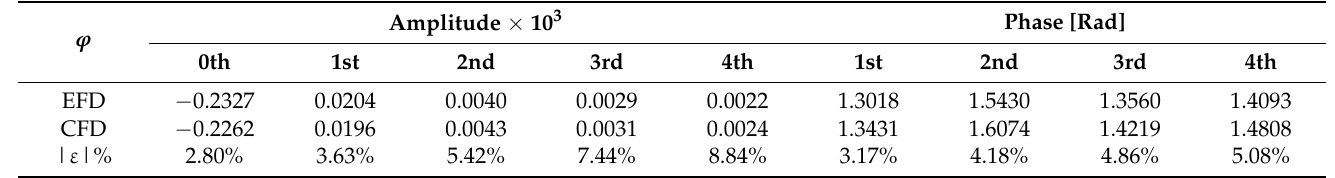
Table 7. Harmonic amplitudes and phases of roll ( ϕ ) for the FRxz ϕθ head waves scenario.